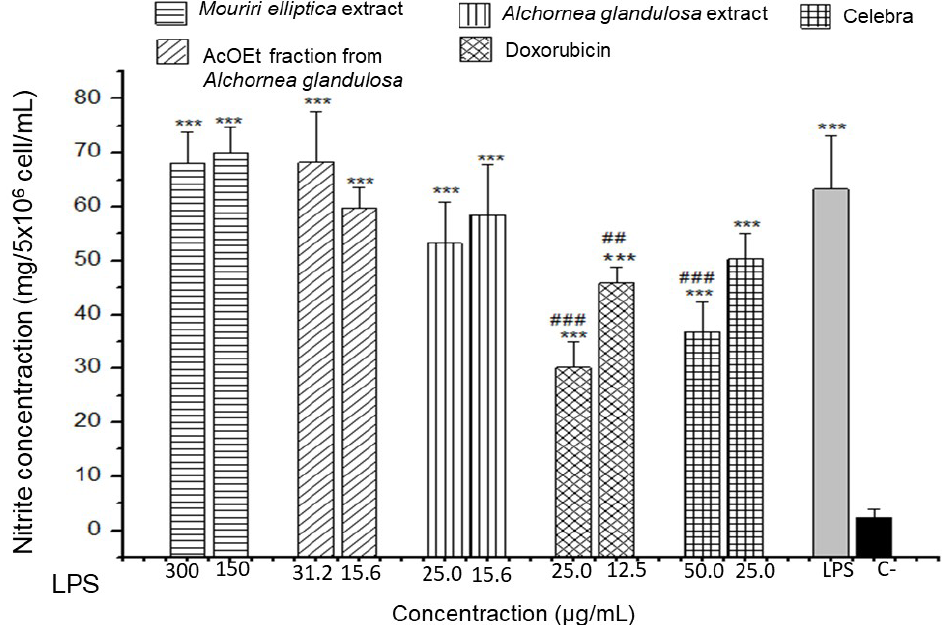
Figure 3. Determination of NO production/inhibition in culture of peritoneal macrophages of mice bearing Ehrlich’s tumor. The peritoneal exudate cells were incubated under the test conditions with the different extracts, fraction or commercial drugs concomitantly with LPS solution at 10 μg/mL. As a positive control, LPS solution (LPS) was used. As negative control (C-), only cells in culture medium (RPMI-1640-C) were used. The statistical analysis was performed through variance (ANOVA) using the Tukey post-test. *** P < 0.001 when compared to the negative control. ### P < 0.001, ## P < 0.01 when compared to the positive